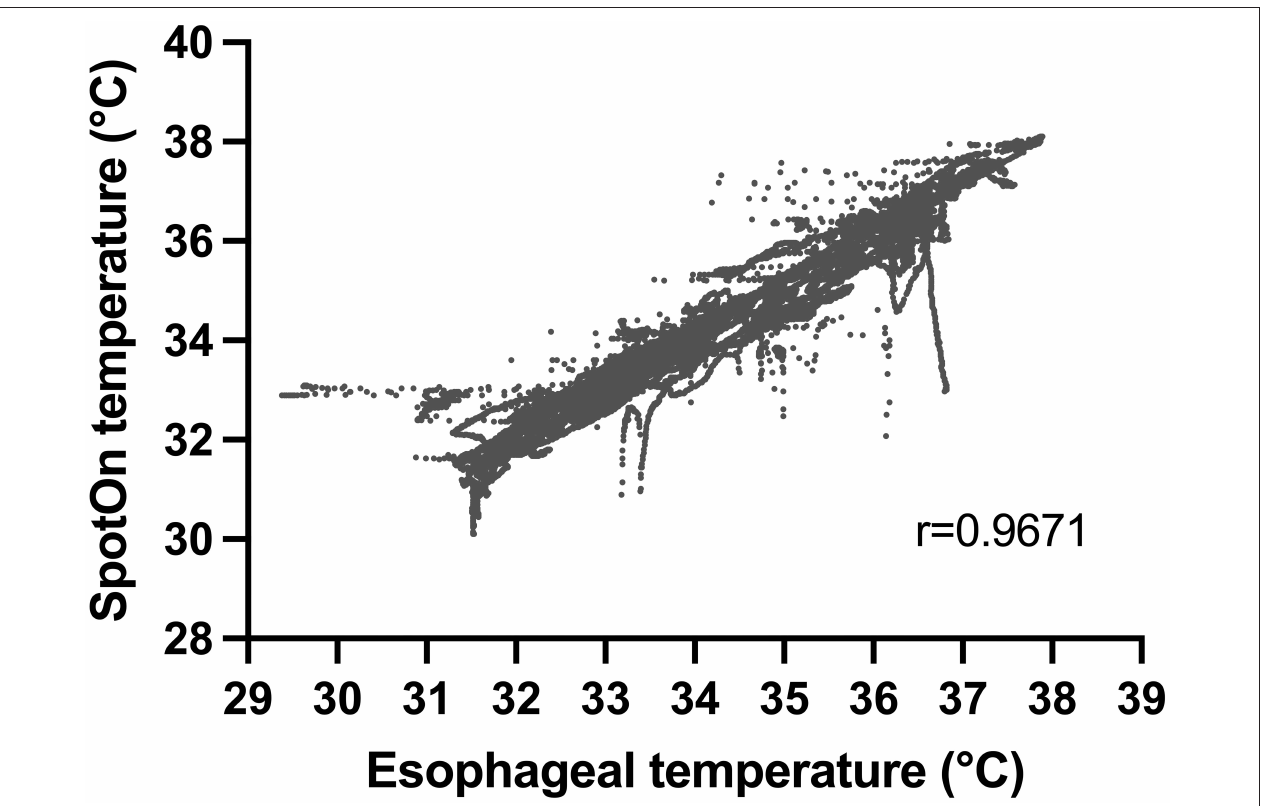
FIGURE 4 | Correlation between temperature measurement using SpotOn TM and the esophageal temperature probe.